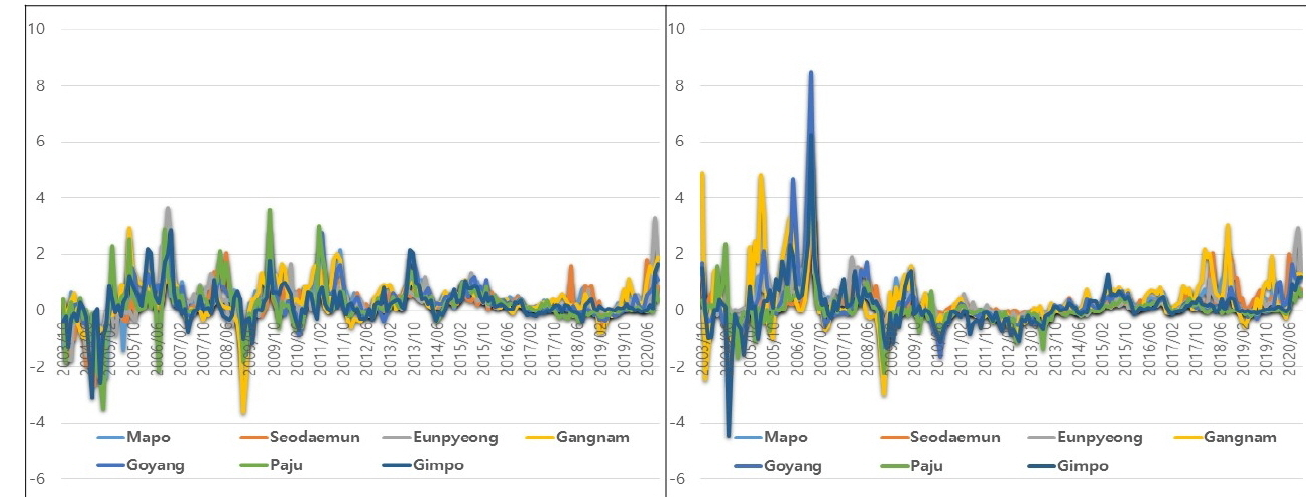
Figure 2. Trends in jeonse price (left) and sales price (right) in the study area.